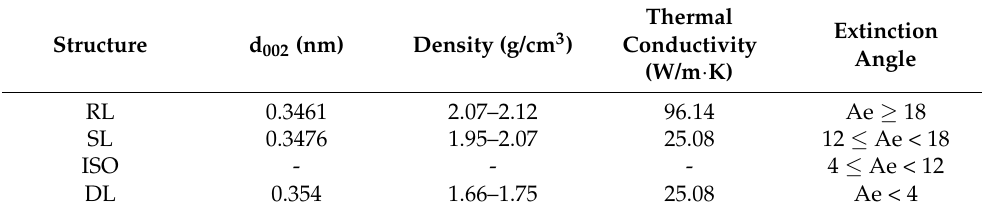
Figure 4. Microstructures of the pyrolytic carbons through a polarized light microscope: ( a ) rough layer; ( b ) smooth layer; ( c ) isotropic layer.